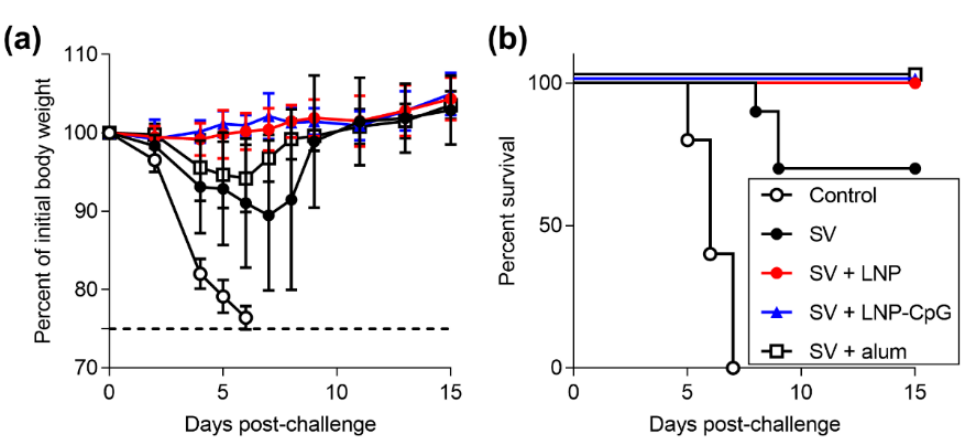
Figure 5. Protective effects against influenza virus challenge. Mice were subcutaneously immunized with the SV alone, SV plus LNP, SV plus LNP-CpG, or SV plus alum on day 0. On day 21, mice were challenged with Cal7. ( a ) Percentages of initial body weights and ( b ) survival rates were monitored after challenge with Cal7. n = 10. ( a ) Data are means ± SD.